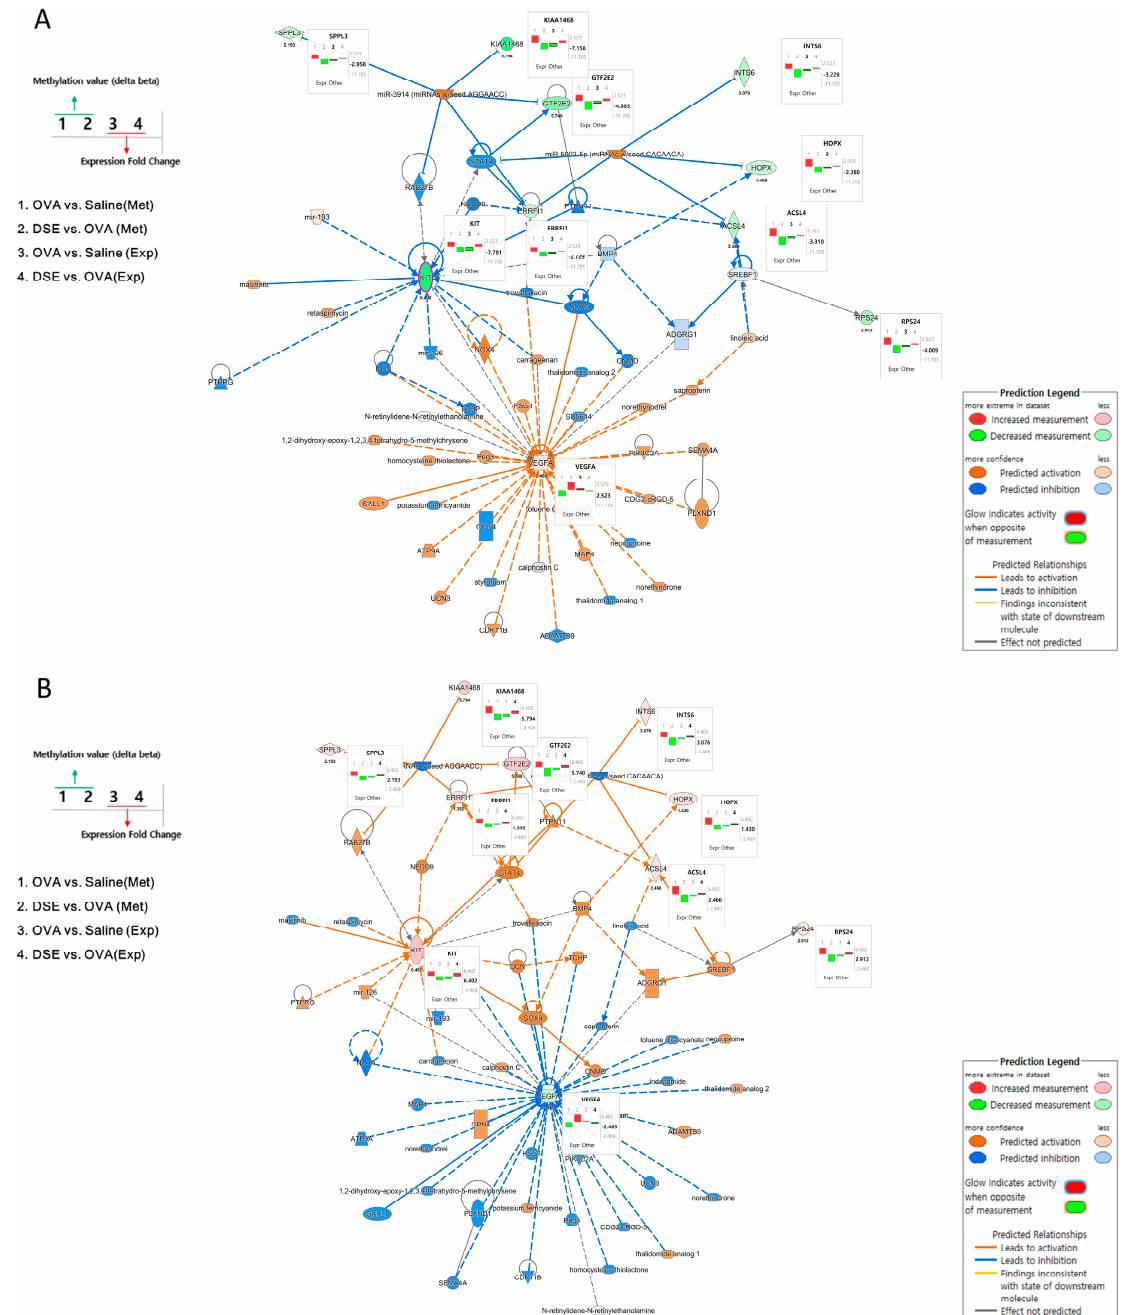
Figure 5. Gene networks associated with anti-asthma effects. Pathway depicts expression levels of anti-asthmatic genes regulated by DNA methylation changes in OVA vs. saline using IPA ( A ). Pathway depicts expression levels of anti-asthmatic genes regulated by DNA methylation changes in DSE vs. OVA ( B ). Bar plots next to genes in the network show changes in methylation and expression levels under each condition. The left panel of the network shows the bar plot legend, and the right panel provides a legend of the IPA network.